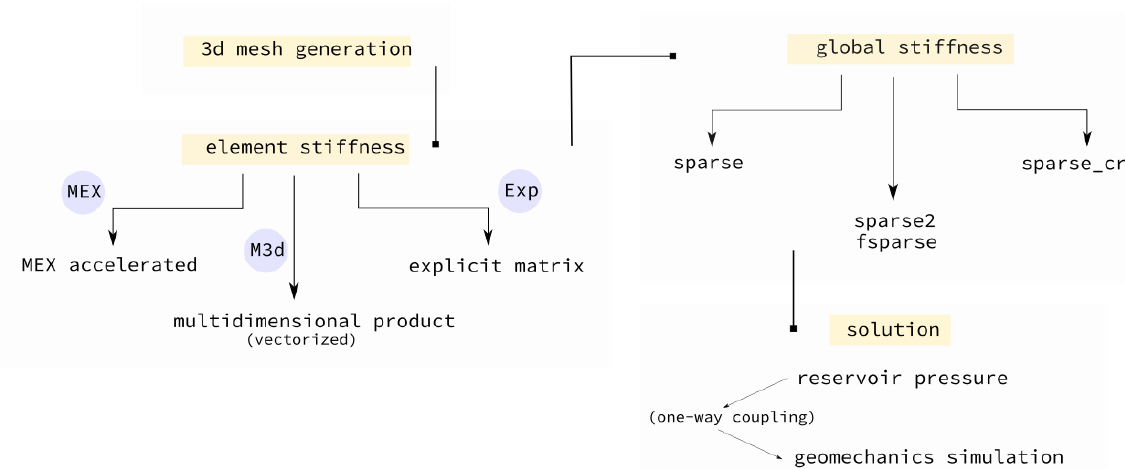
Figure 4. General scheme of the code structure.